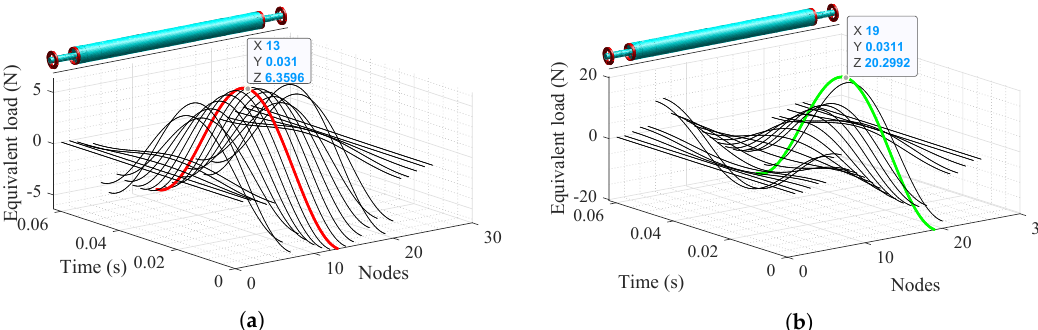
Figure 6. Detecting the unbalance location by identifying the position of the maximum equivalent load in the vertical direction for the tube roll with different sets of measured coordinates: ( a ) With 4 DOFS ( b ) With 6 DOFS.